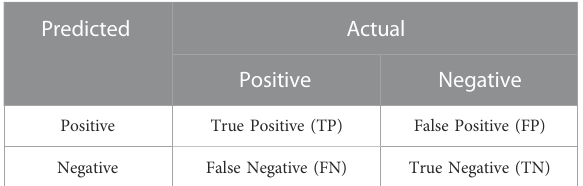
TABLE 2 Confusion